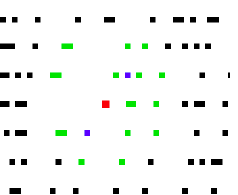
Figure 5: Selection of pixels used for interpolation in our method, red: the height value of this position has to be computed by in- terpolation, green and blue: 20 nearest neighbors of the red pixel in the point cloud, blue: selected cloud points for interpolation, black: unused cloud points